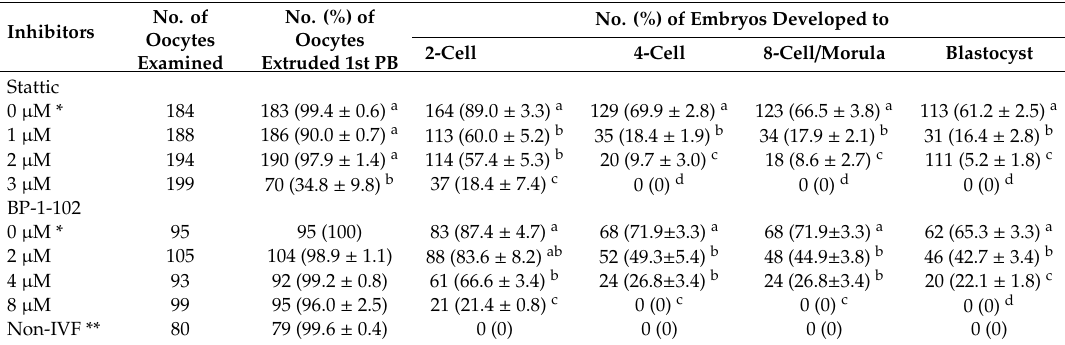
Table 3. E ff ects of pStat3 inhibitors on embryo development after in vitro